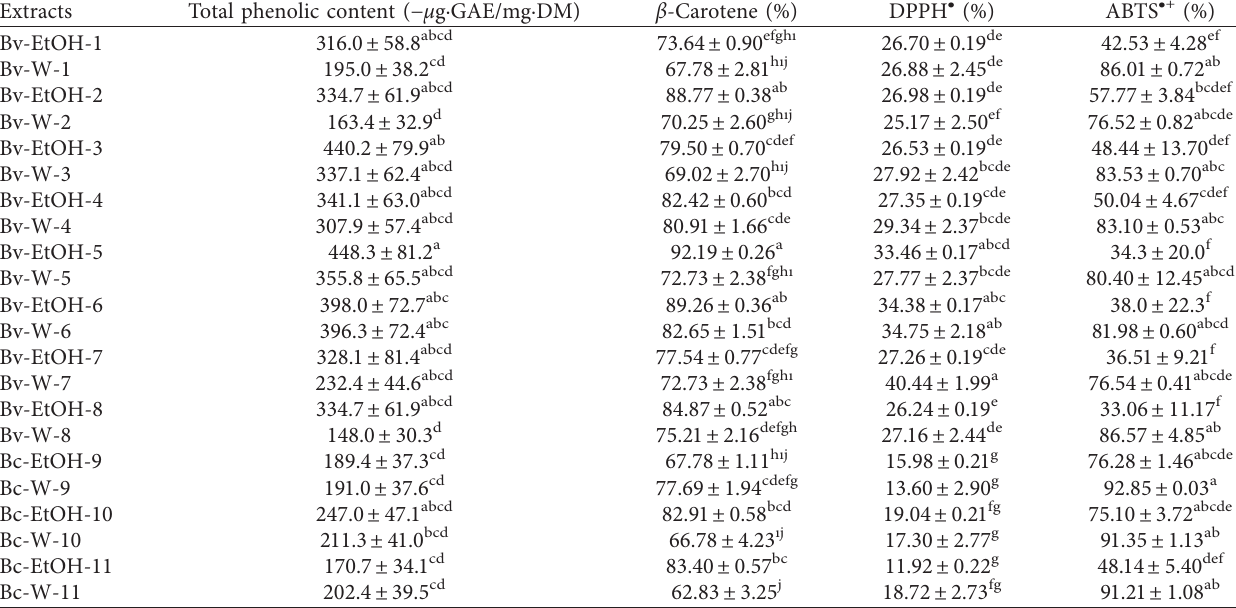
Table 3: Total phenolic content and antioxidant activities of Berberis fruits.